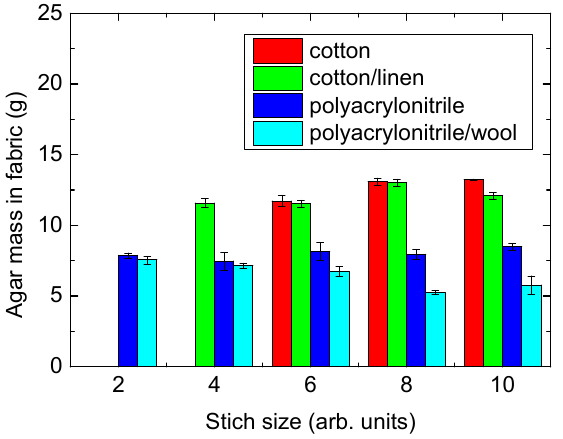
Figure 6. Amount of agar absorbed in the different fabrics.